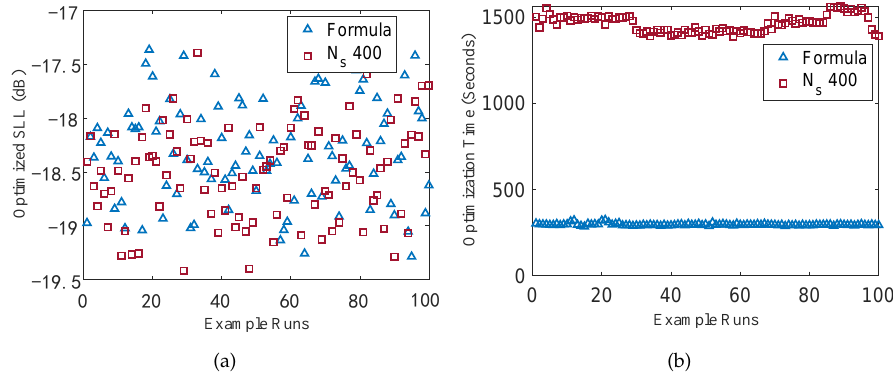
Figure 6. Comparison of the two methods in the synthesis of sparse arrays. ( a ) Comparison of optimized SLLs. ( b ) Comparison of optimization